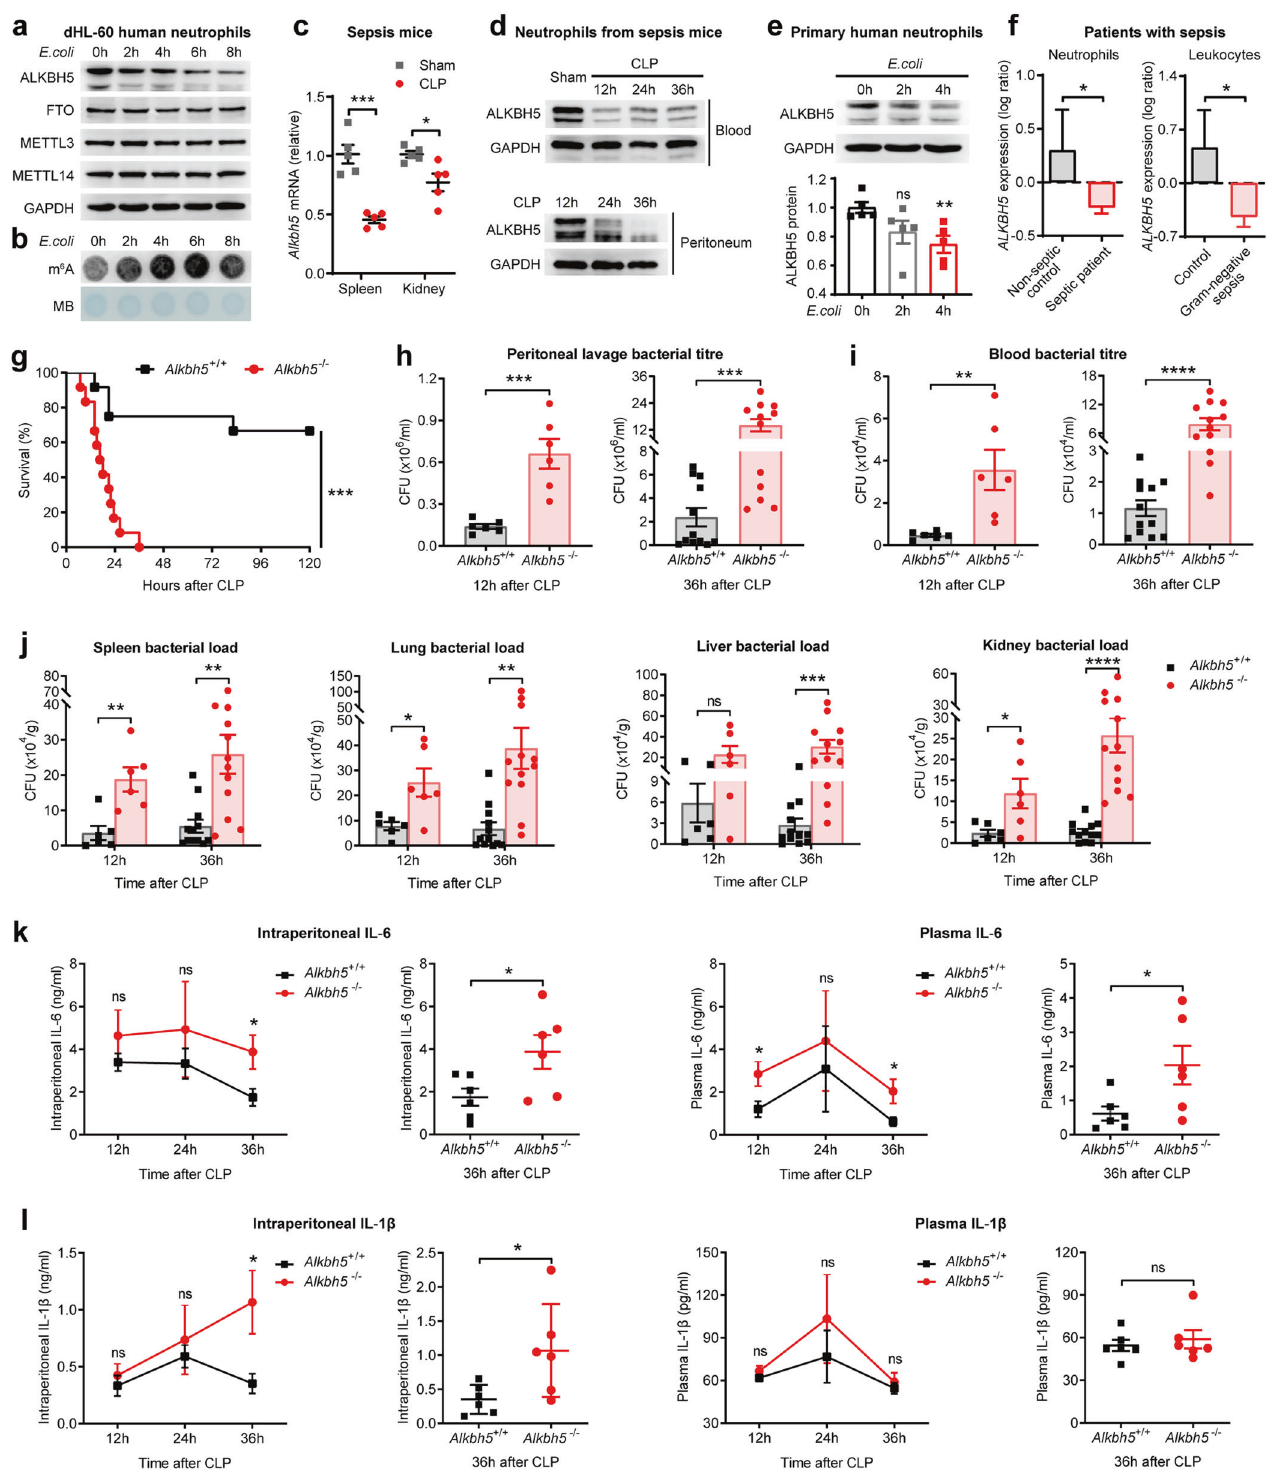
obesity associated (FTO) are responsible for removing m 6 A methylation. 11 m 6 A RNA modi fi cation is extensively involved in immunity and in fl ammation. Emerging evidences show that the m 6 A modi fi cation and its methyltransferases are able to regulate the differentiation and function of innate and adaptive immune cells, such as dendritic cells (DCs), macrophages, NK cells, and T cells. For example, METTL3-mediated m 6 A modi fi cation Signal Transduction and Targeted Therapy (2022)